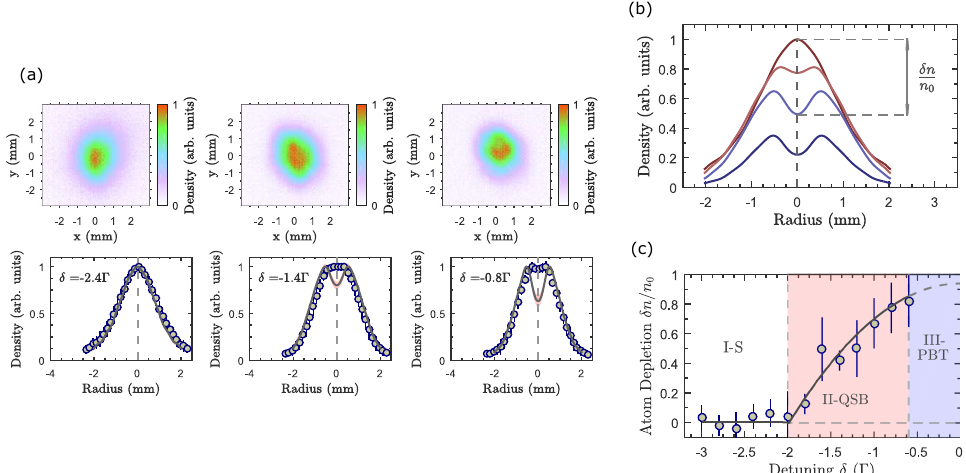
Figure 1. (Colour online.) ( a ) Normalised column density profiles. The ( x , y ) coordinates define the imaging plane, while the z direction coincides with the line of sight of the camera. The lower panel depicts the radial-only column density distribution (grey dots) for different values of δ . The error bars are obtained by making statistics over different sectional cuts in the xy plane, thus quantifying deviations from pure spherical symmetry. The grey line depicts the real atom density profile, obtained as the normalised inverse Abel transform of the column density distribution. The central feature of depleted atom density emerging for higher values of δ results from the saturation of the photon bubble instability and entails a local increase in the photon density. ( b ) Non-scaled atom density profiles in different saturation regimes of the photon bubble instability (varying the laser detuning δ ). The definition of the atom depletion fraction δ n / n 0 is also depicted. ( c ) Phase diagram of the photon bubble instability with the atom depletion fraction (grey dots) and the numerical fit to the theoretical curve describing the saturation of the instability (dark line). Here, three different regimes can be identified, namely, a stable region (I-S), an intermediate region of quasi-static photon bubbles (II-QSB), and a final regime of photon bubble turbulence